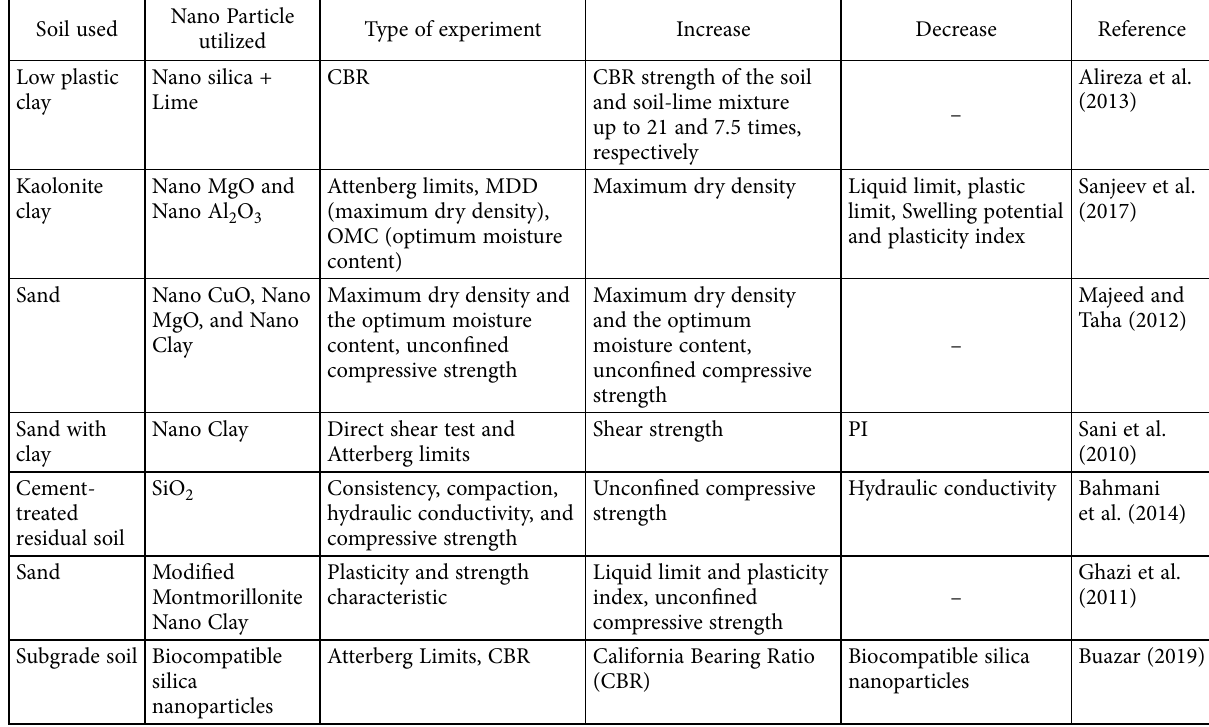
Table 1. Use of nanomaterials for soil stabilization available in open literature